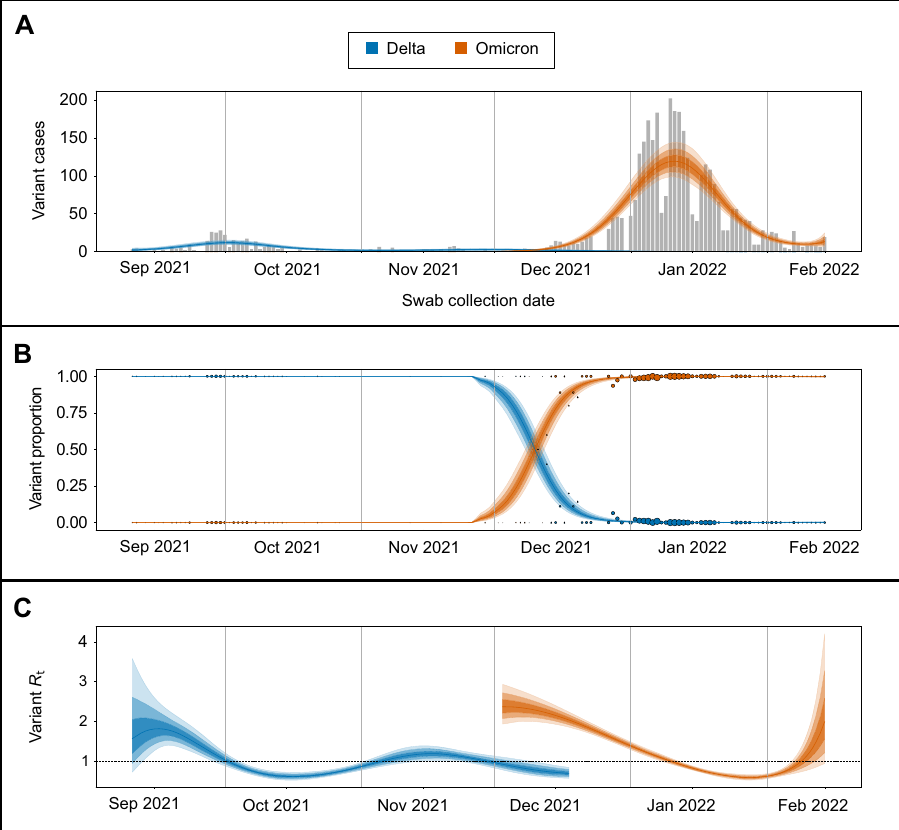
Fig. 4 | Transmission dynamics of Delta and Omicron over study period. A SARS-CoV-2-positive samples (gray bars) against posterior variant-speci fi c inci- denceoverthestudyperiod. B Observed variantproportionof sequenced positive SARS-CoV-2 samples against posterior variant proportion. Radius of points